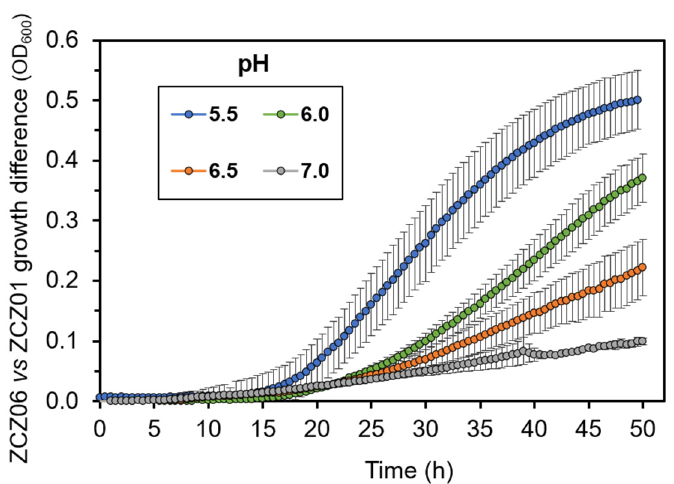
Figure 4. The growth improvement resulting from NHA1 deletion in Ppz1-overexpressing cells is diminished with an increase in external pH. The growth rate of strains ZCZ01 (GAL1:PPZ1 ) and ZCZ06 ( GAL1 : PPZ1 nha1 ∆ ) was compared in liquid medium buffered at different pH levels under conditions of Ppz1 overexpression (1% galactose) and the difference in growth (measured as OD 600 values) calculated and plotted. Data are mean ± SEM from three independent experiments (with three technical replicas).